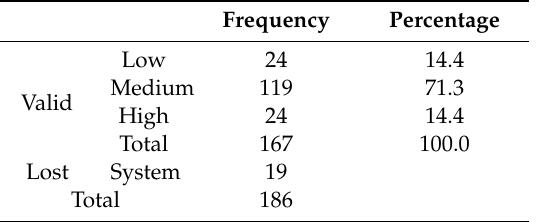
Table 3. Distribution of the sample according to the type of score in SPANE-P.